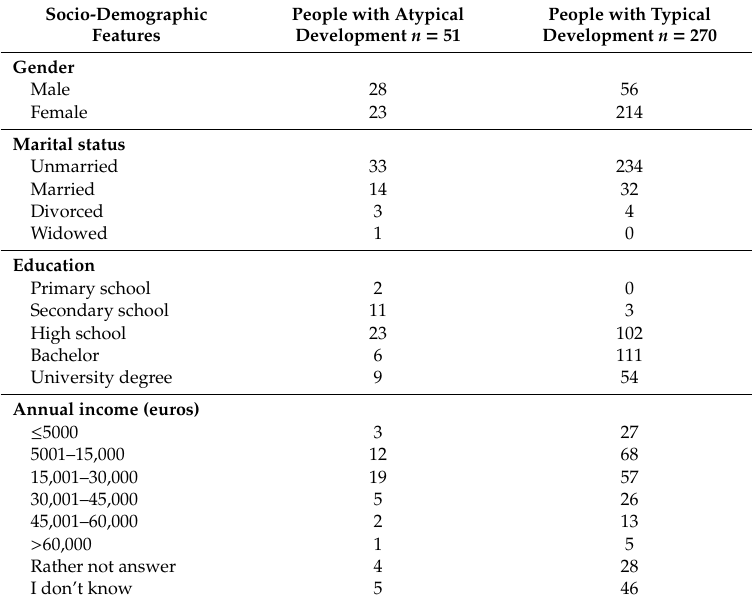
Table 1. Participants’